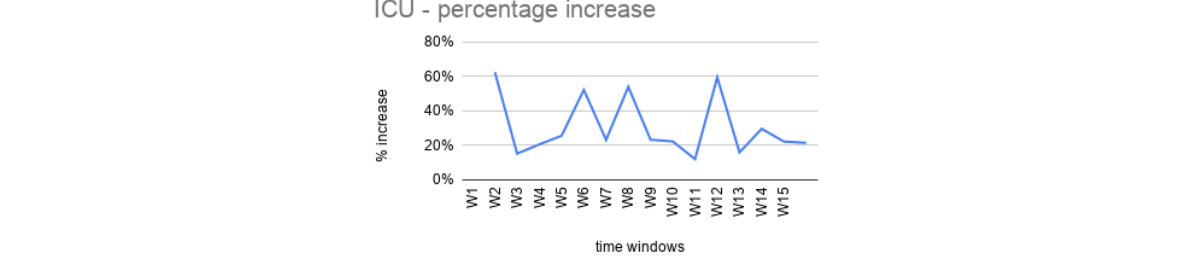
We applied the described method both at the national and regional scale, and we report the results in the next